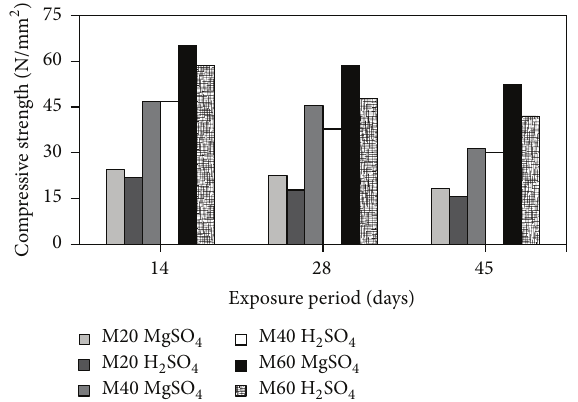
Figure 12: Compressive strength of OPC exposed to magnesium sulphate and sulphuric acid